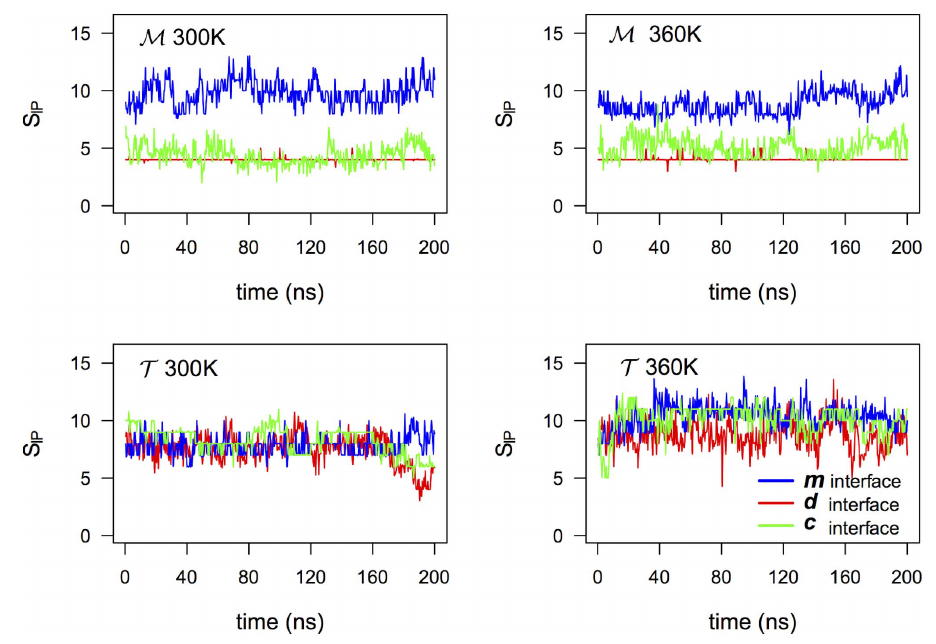
Figure 5. Ion-pairs on the three interfaces. Number of interdomain protein-protein ion-pairs on the 3 different interfaces of the tetramers at 300 K and 360 K. In Fig. S4 the HB timeline for both temperatures is also shown.